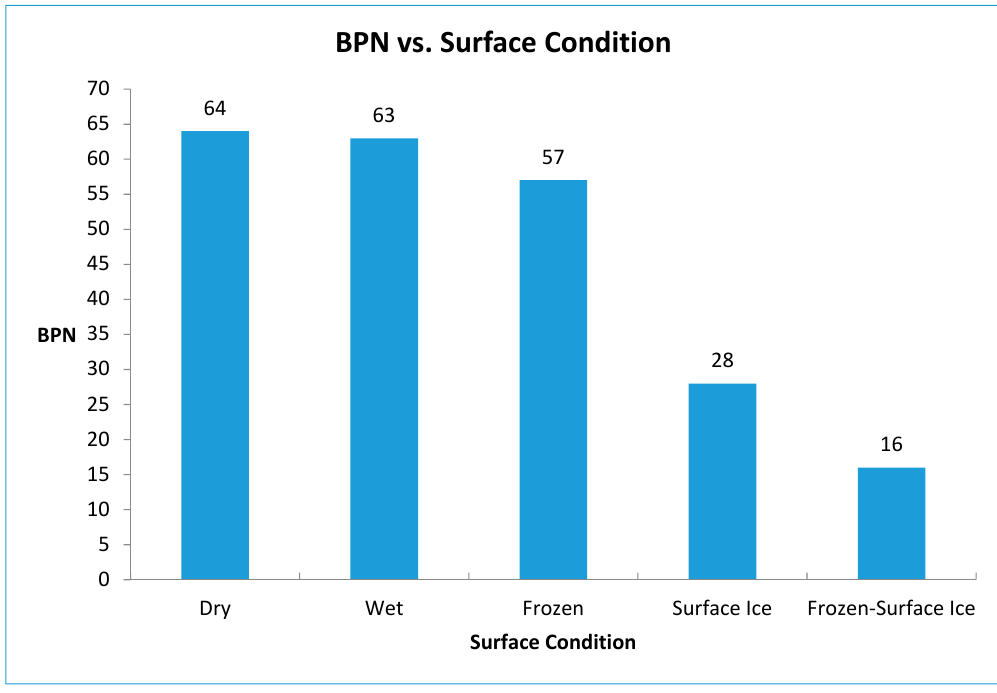
Figure 7. Friction results under different surface conditions.